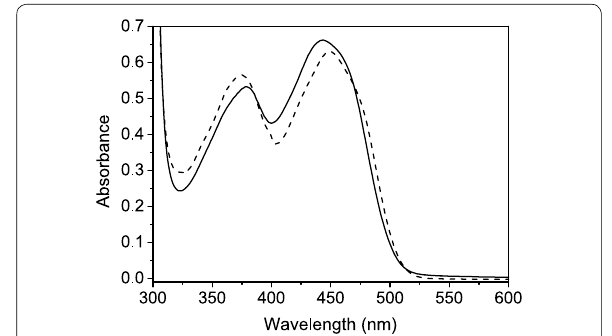
Fig. 1 UV–visible absorbance spectra of ACMO showing the diagnostic flavin peaks at 380 and 440 nm. The black line denotes the spectrum of ACMO while the dashed line is the released FAD cofactor following incubation of ACMO in 0.2% SDS for 10 min at 25 °C in 50 mM HEPES–NaOH pH